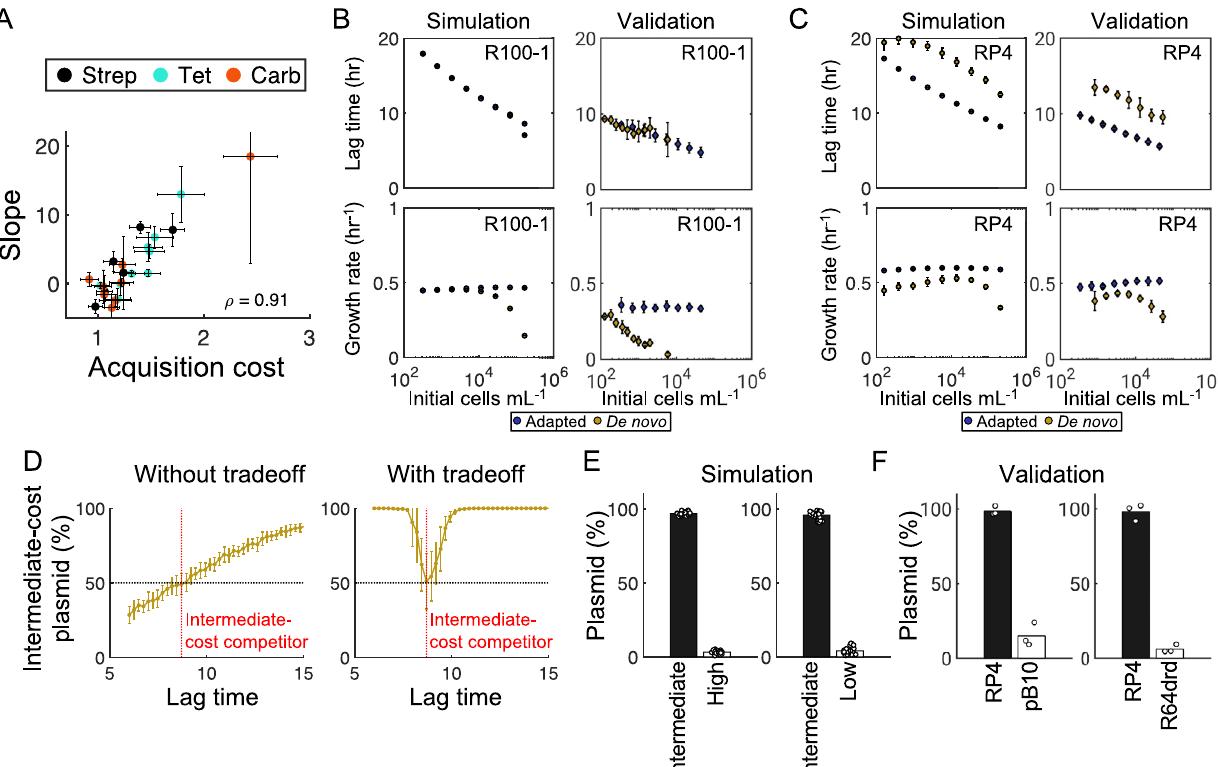
Fig. 4 | Ecological/evolutionary advantage to intermediate acquisition costs. A Acquisition costs for all plasmids (i.e., Fig. 2D) with RB933 recipient is plotted againsttheslopeoftheregressionlinebetweengrowthrateandlagtime(i.e.,from Fig. 3A). The Pearson correlation coef fi cient is reported ( ρ =0.91). Orange, black, and blue marker colors correspond to plasmid selection with carbenicillin, strep- tomycin, or tetracycline, respectively. Markers represent the mean, and horizontal errorbarsrepresentthestandarddeviation,ofacquisitioncostsfortheindicated n number of de novo colonies listed in Supplementary Table 1c; vertical error bars represent the 95% con fi dence interval corresponding to the slope estimates from Fig. 3A. B Left: Simulation predictions for the no-cost plasmid R100-1. X-axis is initialnumberofcells,andy-axisistheaveragepopulationlagtime(top)orgrowth rate(bottom).Right:ExperimentallymeasuredlagtimesandgrowthratesofR100-1 atcorrespondinginitialdensities(x-axis)fordenovo(yellow)andadapted(purple) transconjugants. C Same as 4 B for RP4. D Simulation predictions for pairwise competition outcomes between an intermediate-cost plasmid (red vertical line)